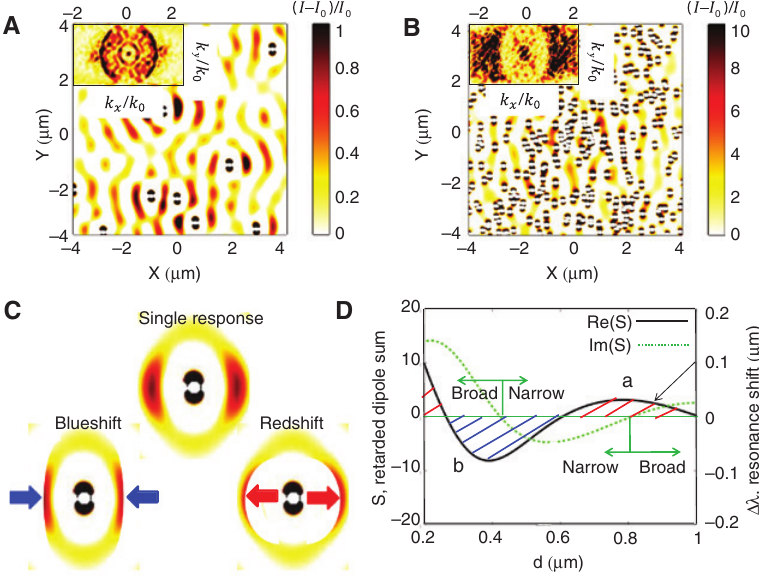
Figure 3: Collective response of randomly distributed nanoholes on a metal surface. Intensity distribution and the corresponding Fourier transforms on the top-left side of the figure. Nanoholes are of R = 50 nm and average spacings (A) d = 800 nm and (B) d = 300 nm. The wave vectors are normalized to k function of d using dipole–dipole interaction semianalytical approach and the concept of the retarded dipole sum S .